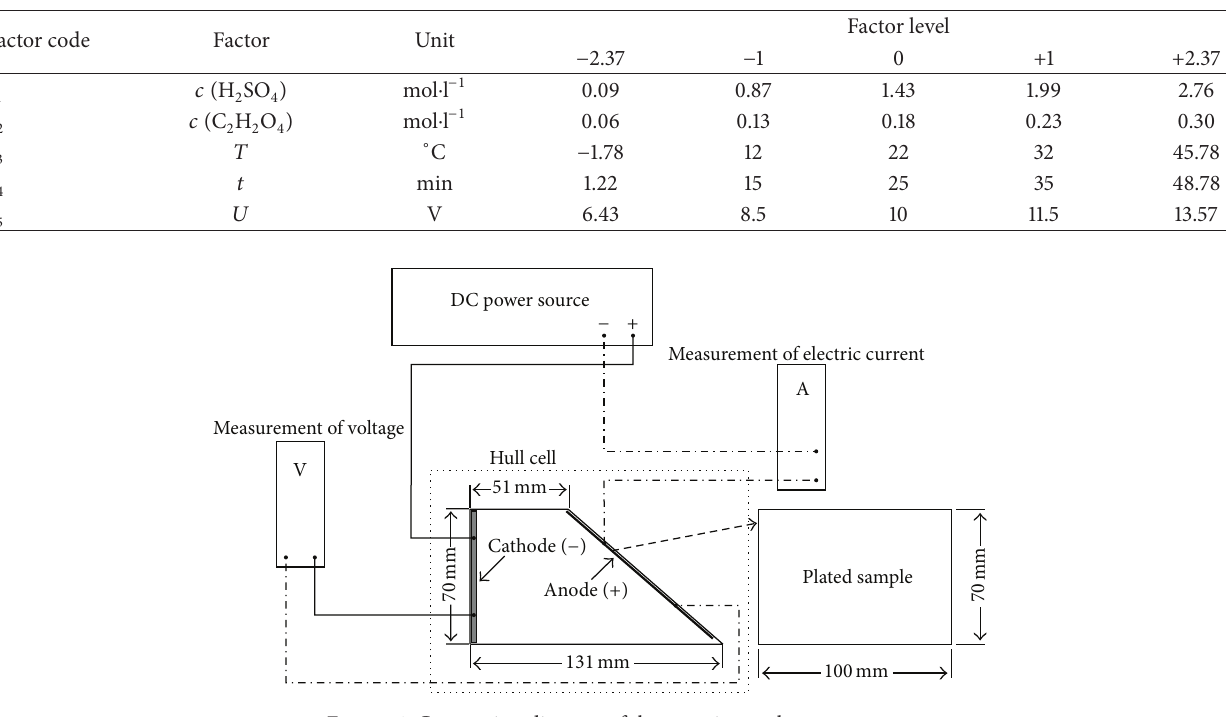
Table 2: Conditions of the performed experiment.